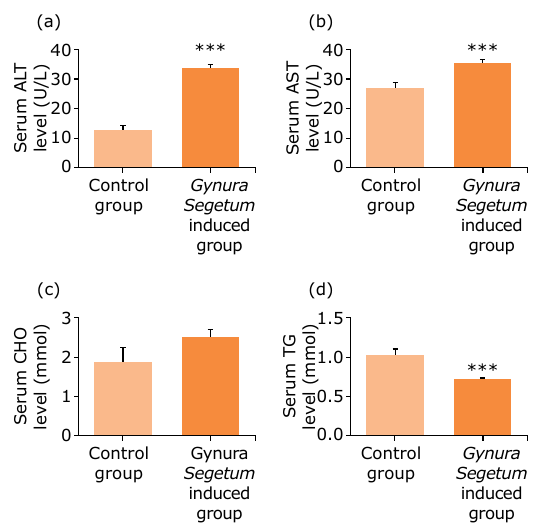
Figure 4 - Gynura segetum induced the changes of histopathology with Masson staining in mice (n = 10). Liver specimens were collected at five weeks after G. segetum administration, and liver sections were stained with Masson staining. Collagen fibers are blue, muscle fibers are red. (a) Control group; (b) G. segetum -induced group. Original magnification